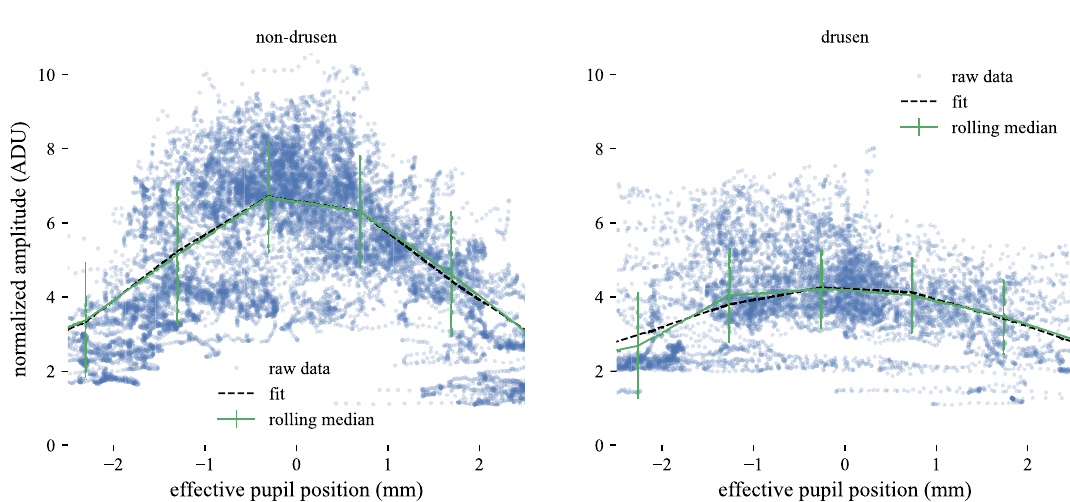
Figure 6. Differences in raw data, smoothed data, and Gaussian fits, between unaffected and drusen-affected IS/OS. When plotted side-by-side, differences in the dependence of IS/OS amplitude on effective pupil position are readily apparent. Raw data are shown with blue circles, while the rolling median and Gaussian fitting function are shown with green lines and black dashed lines, respectively. The Gaussian fits match the smoothed data closely, confirming that the Gaussian equation is a good model for the data in both cases. The raw data appear to be more strongly dependent on effective pupil position in healthy retina than drusen-affected retina, and the amplitude and width of the fitting functions are different, with both parameters being greater in the non-drusen